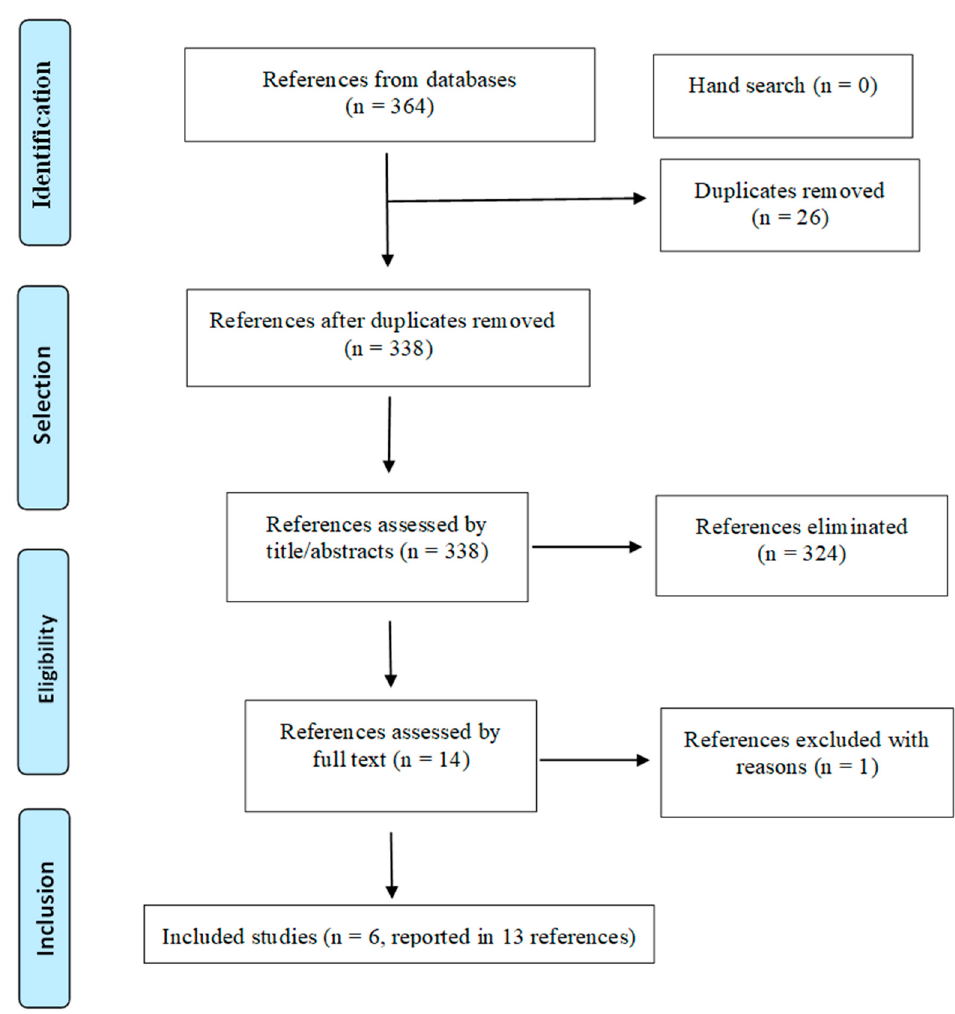
Figure 1. PRISMA flowchart of the study selection process.